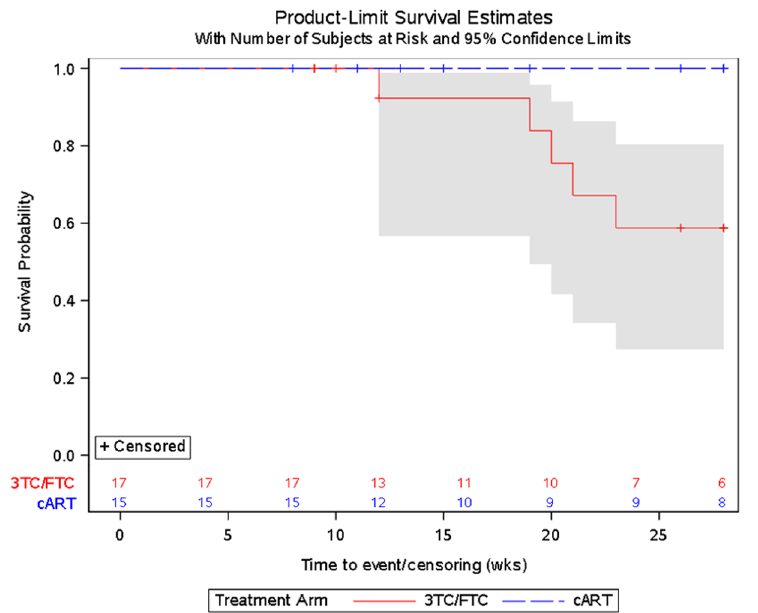
Fig 2. Probability of not experiencing immunologic failure.